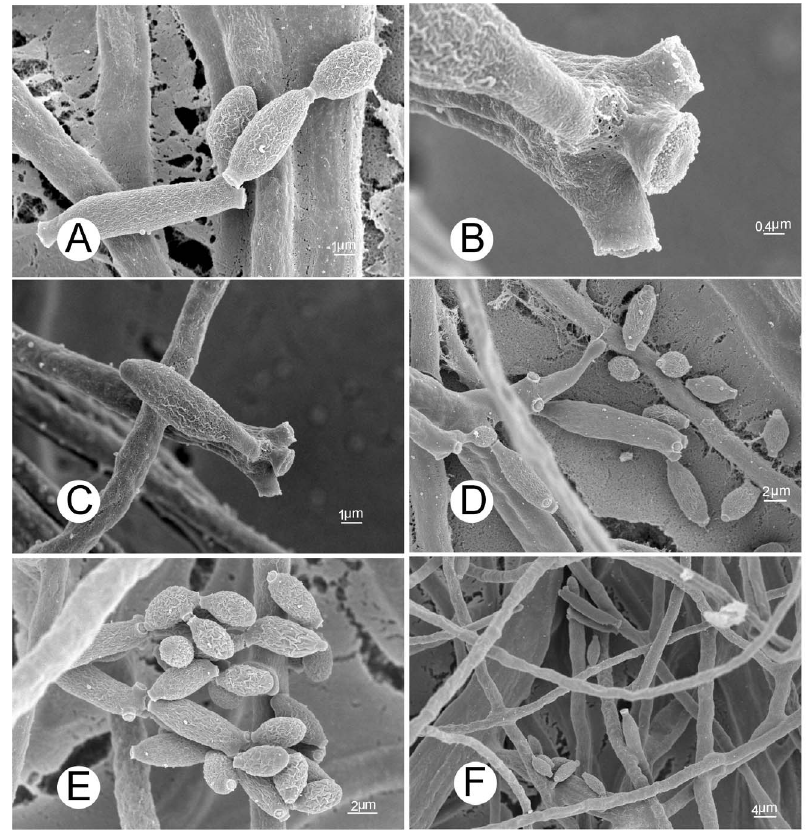
Figure 3. Morphological features of Cladosporiumcladosporioides under a scanning electron microscope. A : Conidial chains ( 6 7,000), B : Scars on a conidiophore ( 6 20,000), C : Top view of a conidiophore with scars ( 6 7,000), D : scars on a secondary ramoconidium ( 6 4,000), E : Conidia on conidiophores ( 6 5,000), F : Hyphae ( 6 2,000).